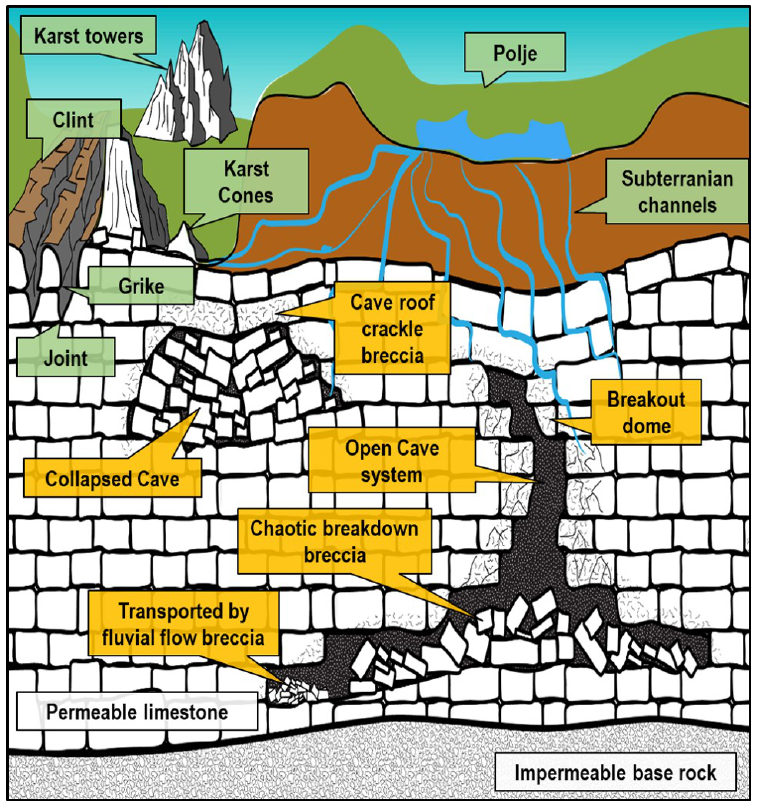
Figure 2. Karstification features. Surface and subsurface features are indicated by green and yellow labels, respectively. Figure is inspired by